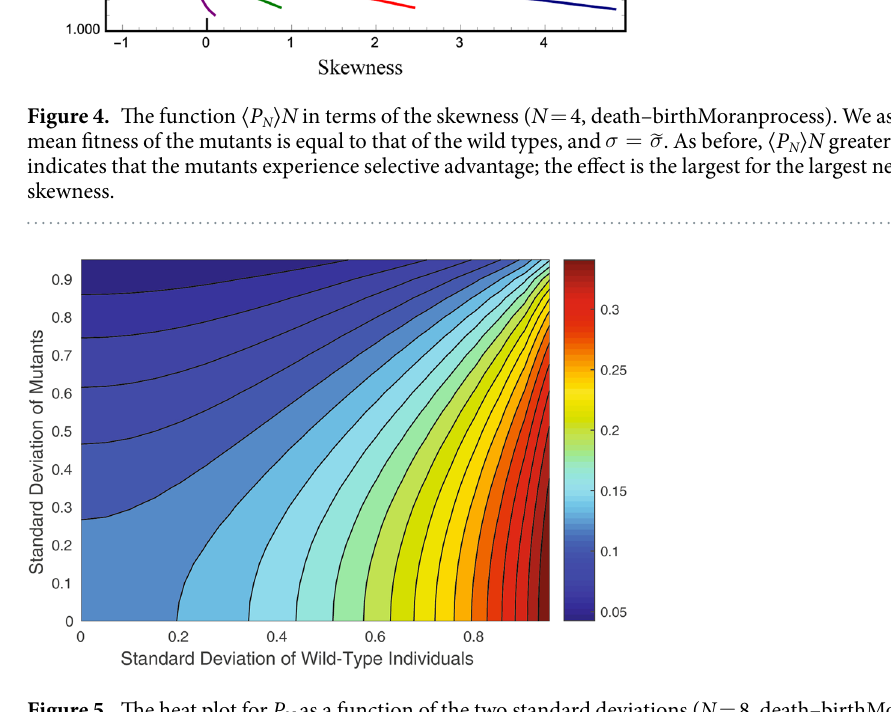
Figure 5. The heat plot for P N as a function of the two standard deviations ( N = 8, death–birthMoranprocess). The amount of variance in the distribution of fitness values of the wild types (mutants) increases along the horizontal (vertical) axis. The largest fitness advantage of mutants (in red, right bottom corner) corresponds to the largest variation of the wild types and smallest variation of the